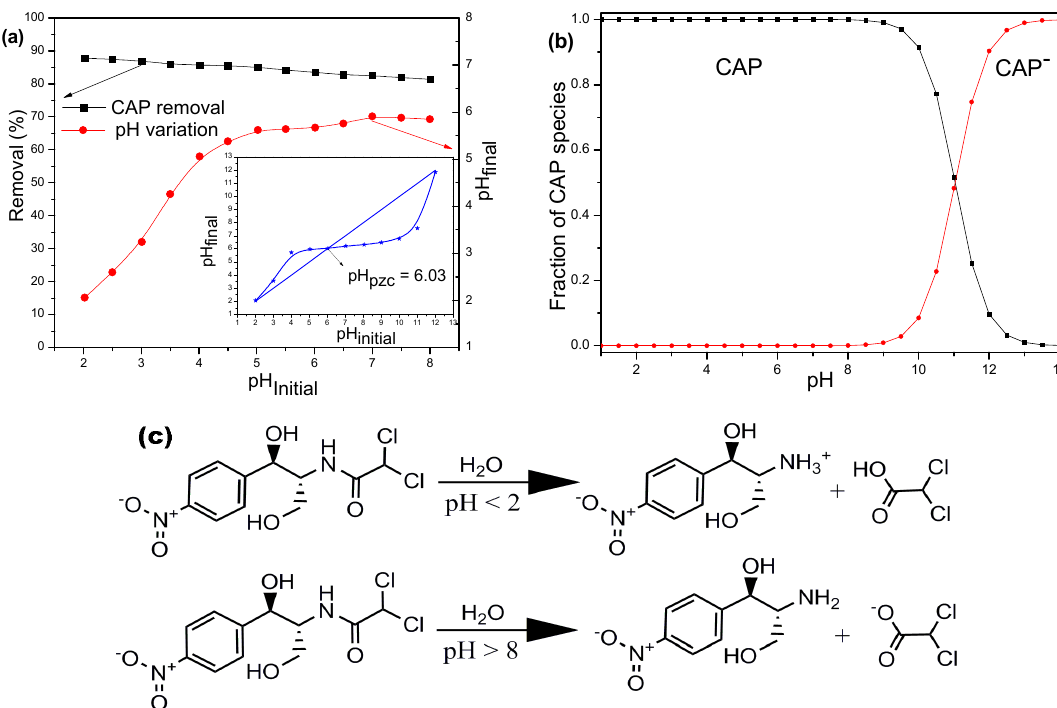
Figure 5. Effect of the initial pH on equilibrium pH and CAP removal on AC, and pH pzc of AC (inset) ( a ). The fraction of CAP species ( b ) and the hydrolytic equation of CAP (c). (C 0 = 0.2 mmol/L, dosage = 30 mg/50 mL, time = 24 h, temperature = 25 °C).